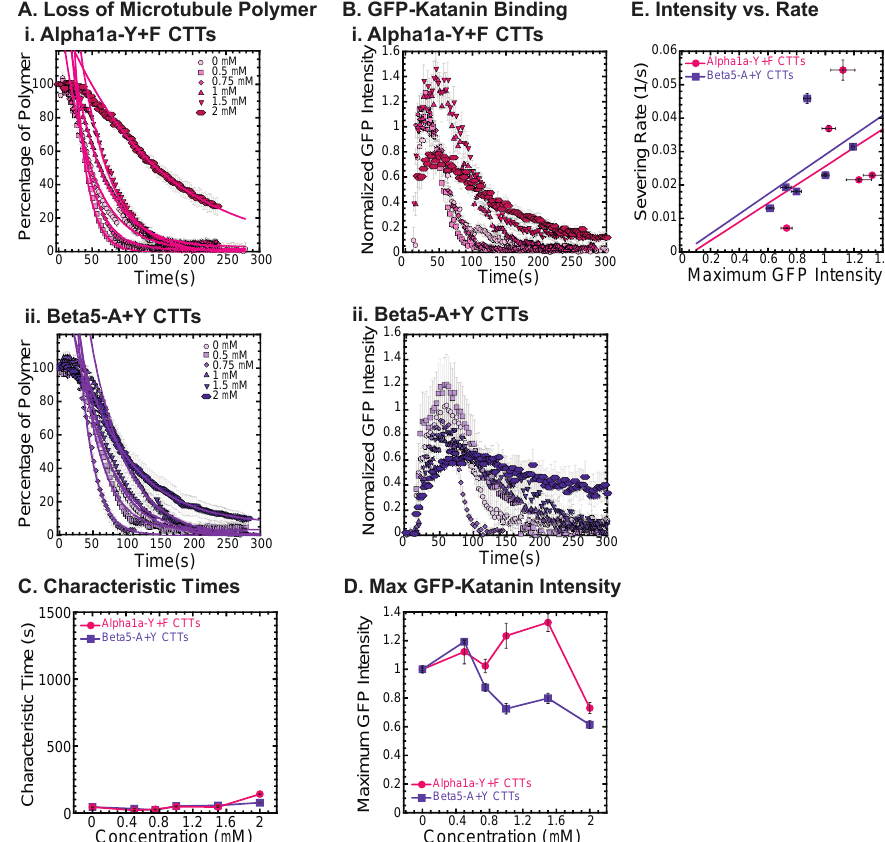
Figure 5. Katanin severing and binding not inhibited by artificially constructed CTTs. ( A ) Loss of polymer caused by increasing concentration of ( i ) alpha-Y+F CTTs (magenta) and ( ii ) beta-A+Y CTTs (purple). All datasets were fit to exponential decays because these CTTs did not inhibit severing significantly as the amount of inhibitor is changed from no inhibitor (0 µ M, lightest shade circles), low inhibitor (0.5 µ M, light shade squares; 0.75 µ M, light shade diamonds), medium inhibitor (1 µ M, medium shade triangles with point up), to highest inhibitor (1.5 µ M, darker shade triangles with point down, 2 µ M, darkest shade hexagons). Each dataset is fit with a best fit equation to an exponential with best fit parameters provided in Supplemental Information Table S8. ( B ) The data for the GFP- katanin binding by increasing concentration of ( i ) alpha-Y+F CTTs (magenta) and ( ii ) beta-A+Y CTTs (purple). The data were normalized by the maximum when there was no inhibitor (0 µ M, lightest shade circles). Data for low inhibitor (0.5 µ M, light shade squares; 0.75 µ M, light shade diamonds), medium inhibitor (1 µ M, medium shade triangles with point up), to highest inhibitor (1.5 µ M, darker shade triangles with point down, 2 µ M, darkest shade hexagons) are shown. ( C ) The characteristic decay times for loss of polymer as a function of concentration for alpha-Y+F (magenta circles) and beta-A+Y CTTs (purple squares). Error bars represent the uncertainty in the fit parameters. ( D ) The average normalized maximum for GFP-katanin binding to microtubules for alpha-Y+F (magenta circles) and beta-A+Y CTTs (purple squares). Error bars represent the standard deviation of the average. ( E ) Plotting the rate of microtubule severing as a function of average normalized